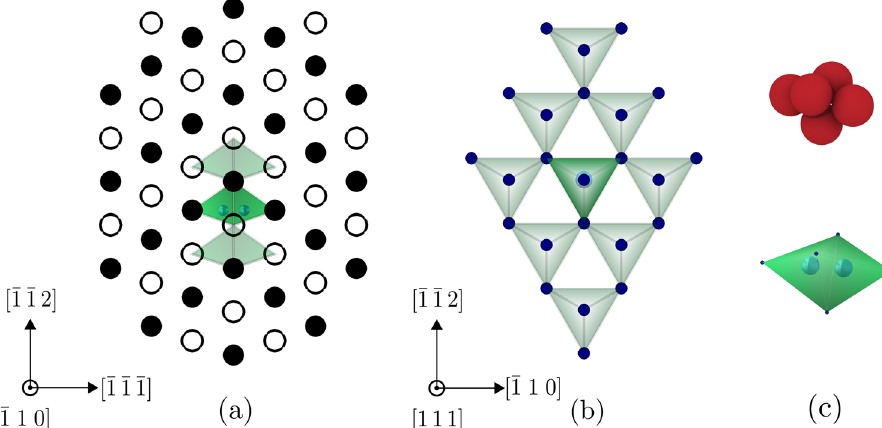
Fig. 7 The polyhedral unit model of the Σ 3(111) GB is illustrated. a , b The atomistic structure and the dual-tetrahedral units of the twin GB, viewed along the tilt axis ½ 110 (cid:5) and along the plane normal [111], respectively, are shown. Due to the translational symmetry of the GB, the unit-cell contains only one dual-tetrahedron, which is highlighted. c The dual-tetrahedron along with the corresponding atoms and the VV- spheres are shown. As discussed in the article, the VV-spheres of the dual-tetrahedron in the twin GB do not ( θ , ϕ ). The Σ 3(111) GB has the orientation ( θ , ϕ ) = (0,0), and Σ 3 ð 211 Þ corresponds to (90°,0). The asymmetric tilt Σ 3 ½ 011 (cid:5) GBs corre- spond to set of orientations with ϕ = 0 .